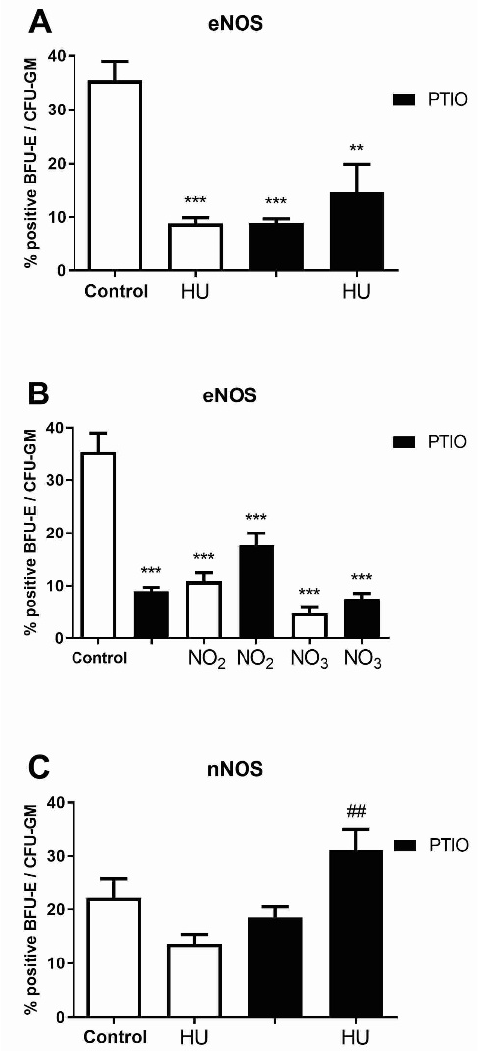
Figure 6. NOS levels in mouse ex vivo BFU-E/CFU-GM colonies. Frequency of eNOS positive cells in mice in vivo treated with hydroxyurea ( A ), sodium nitrite (NO 2 ), and sodium nitrate (NO 3 ) ( B ), with or without PTIO. Frequency of nNOS positive cells in mice treated with hydroxyurea ( C ) with or without PTIO. The correspond immunocytochemistry slides are in Supplemental Figure S3. Values are mean ± SEM ( n = 5). ** p < 0.01 and *** p < 0.001 vs. non-treated mice (Control); ## p < 0.01 vs. HU treated only.